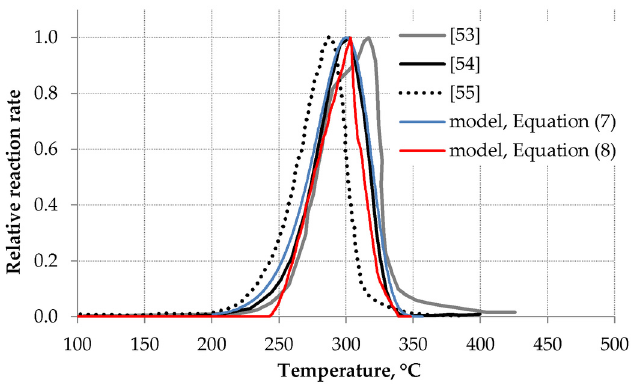
Figure 9. Comparison of modeled pyrolysis rate with experimental data [53–55].